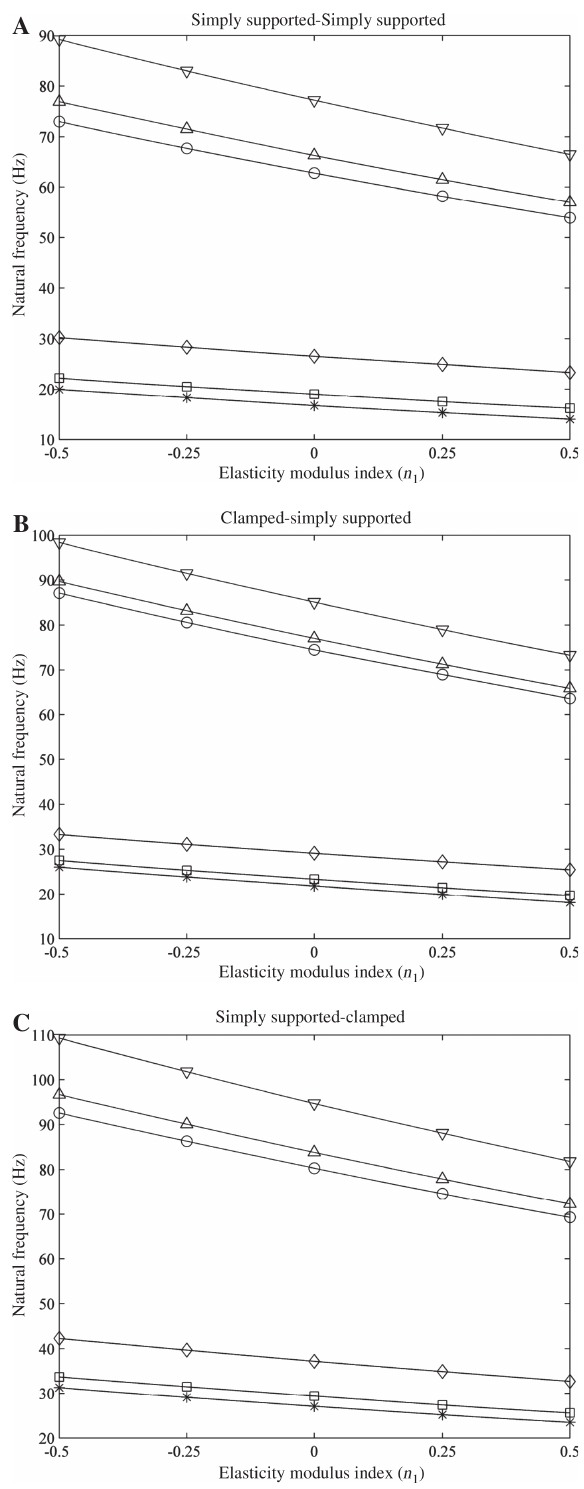
variations on the natural frequency of the disc Figure 2 Effects of n 1 for (A) S-S, (B) C-S, and (C) S-C boundary conditions. * ( m = 0; n = 1), ○ ( m = 0; n = 2), □ ( m = 1; n = 1), ∆ ( m = 1; n = 2), ◊ ( m = 2; n = 1), ∇ ( m = 2; n =